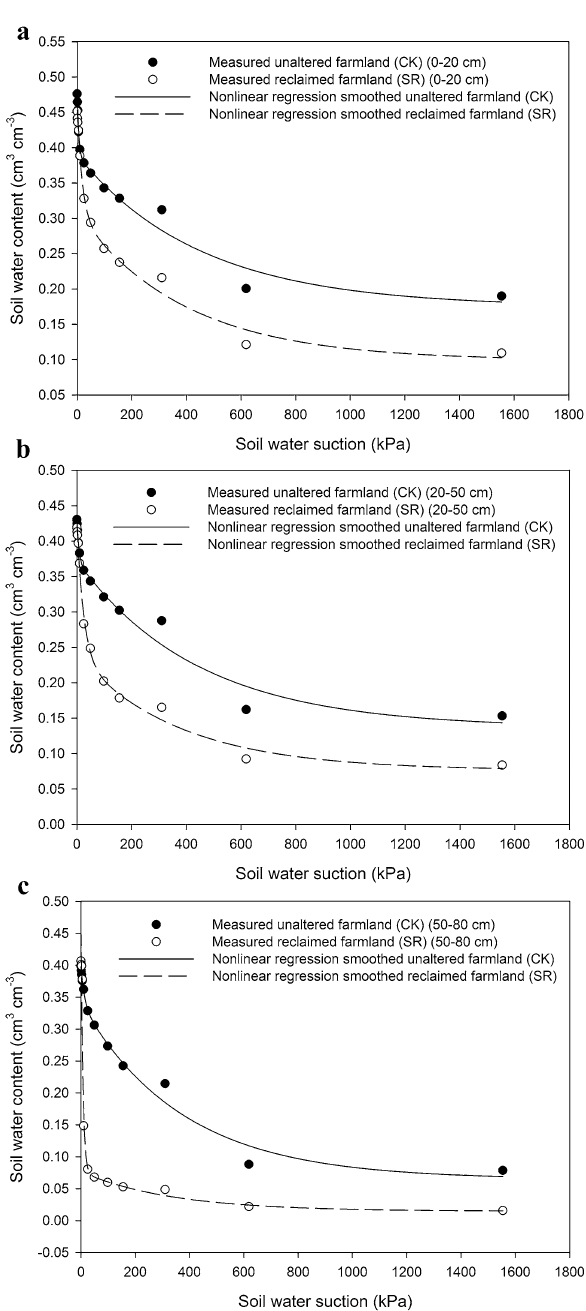
Fig. 4 Relationship between the volumetric water content and water suction of surface soil, subsoil and substratum soil of the reclaimed and unaltered farmlands. a Surface soil (0–20 cm), b subsoil (20–50 cm), c substratum (50–80